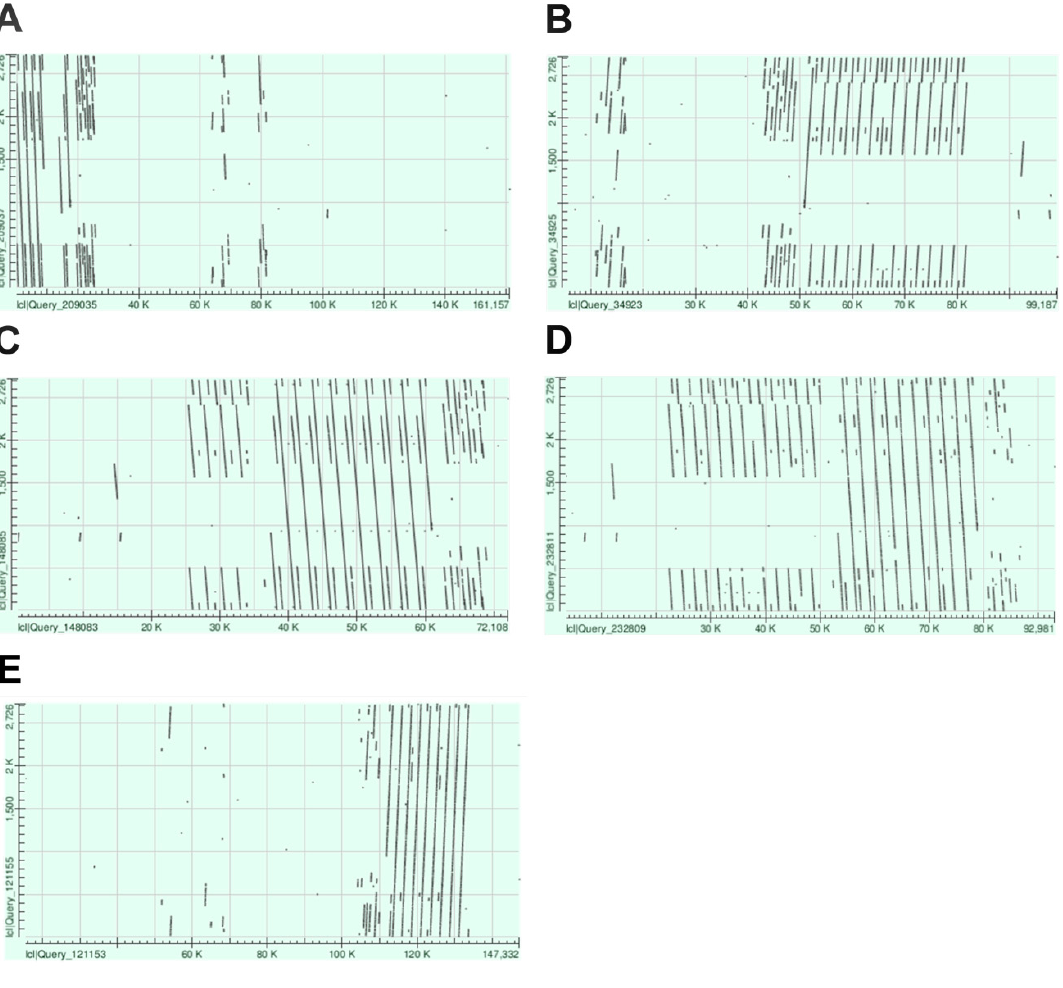
Figure 2. Dot plots showing position and arrangement of TaeCsTr99 repeat in ( A ) ChrUn8536, ( B ) interval 9.06 Mb to 9.16 Mb of 7D pseudomolecule of Triticum 3.1 assembly [12] ( C ) 72-kb Illumina contig of BAC clone 28N04, ( D ) 99.8-kb nanopore read 51ef9015 of BAC clone 28N04, ( E ) 148-kb nanopore read f24cdcf5 of BAC clone 104G18.